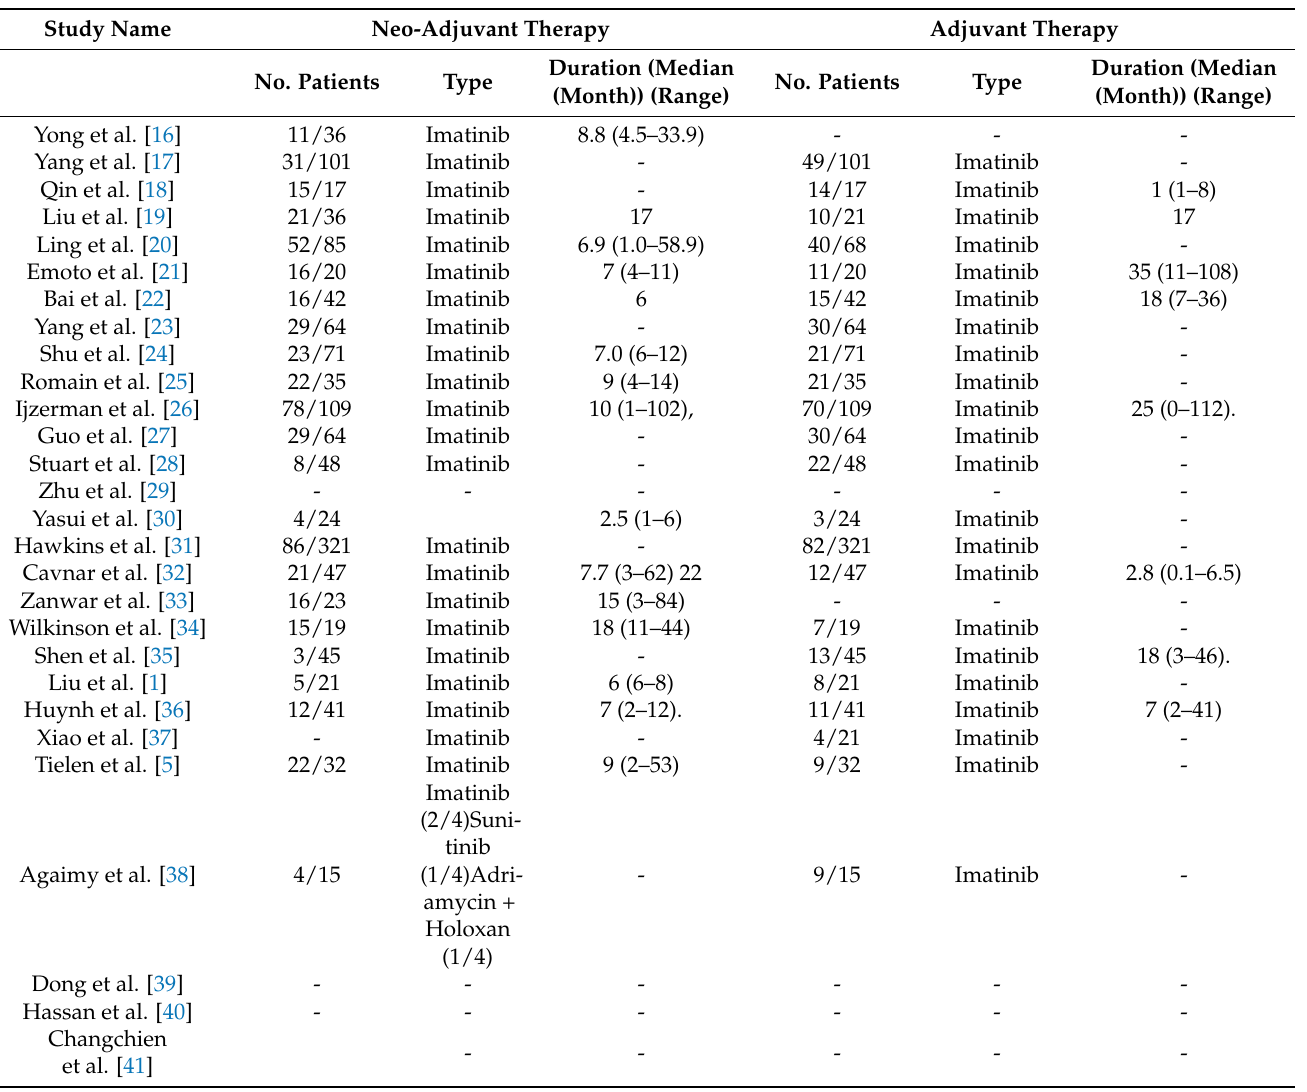
Table 3. Summary of Chemotherapy